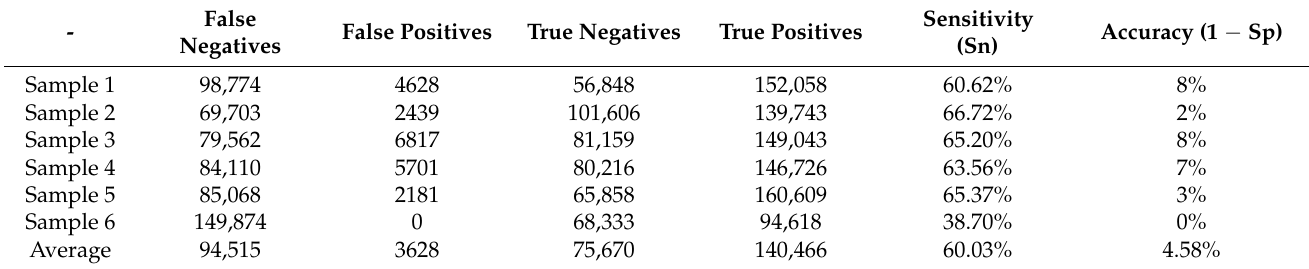
Table 3. Performance analysis in sensitivity and